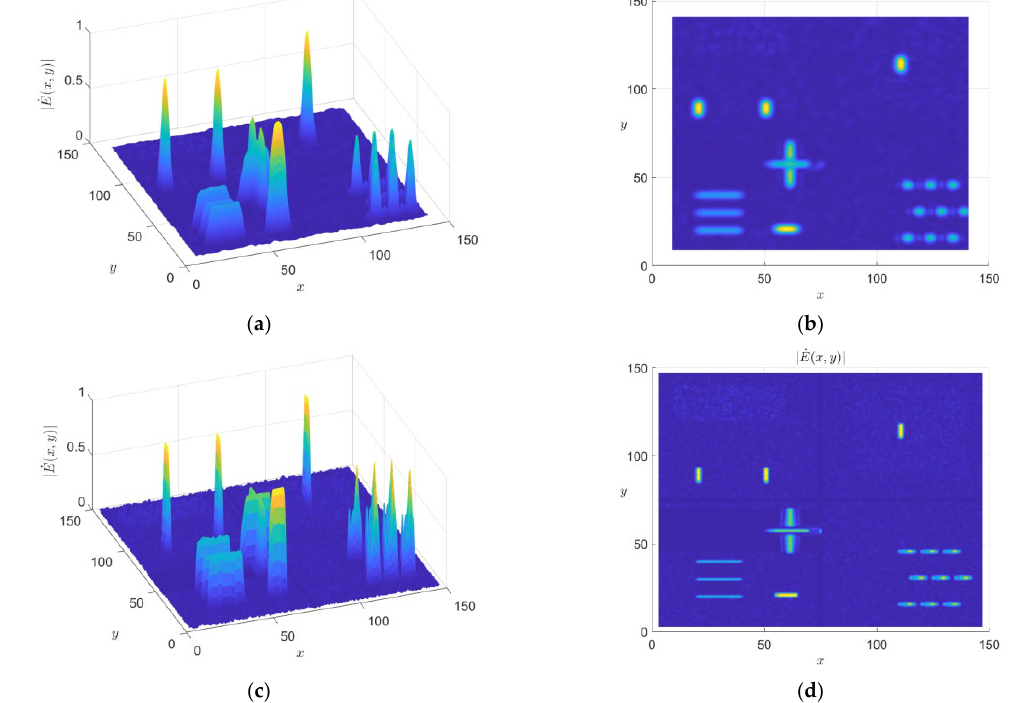
 (cid:12) (cid:12) . → |Y(r)| : ( a ) for the uncertainty function with (cid:12) (cid:12) Y ( r ) (cid:12) (cid:12) : ( a ) for the uncertainty function